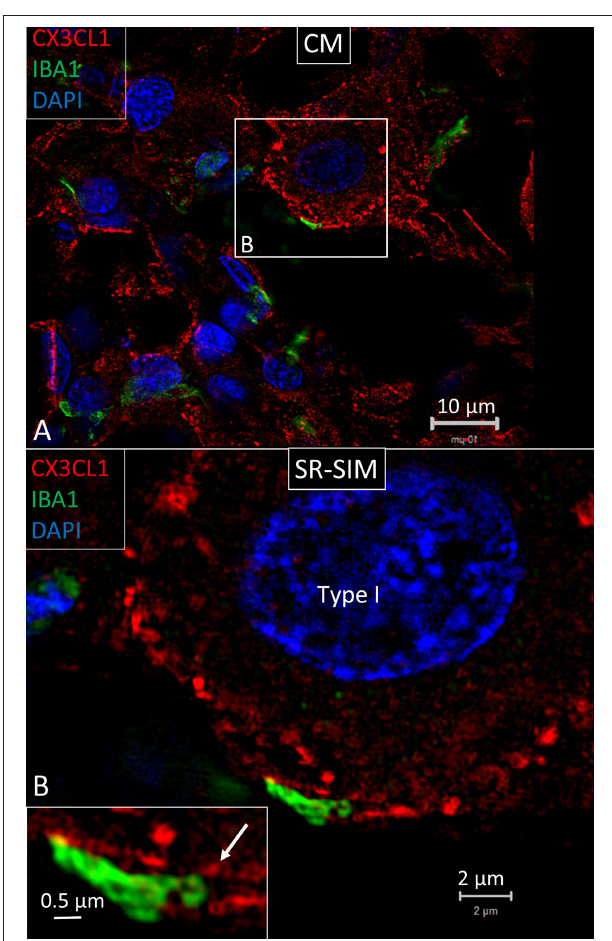
FIGURE 9 | (A) SR-SIM showing expression of fractalkine in the human spiral ganglion. Framed area is magnified in (B) . (B) An IBA1 cell process adheres to the cell coat of a type I spiral ganglion cell. It contains a small cell process projecting into the nerve cell soma (arrow in